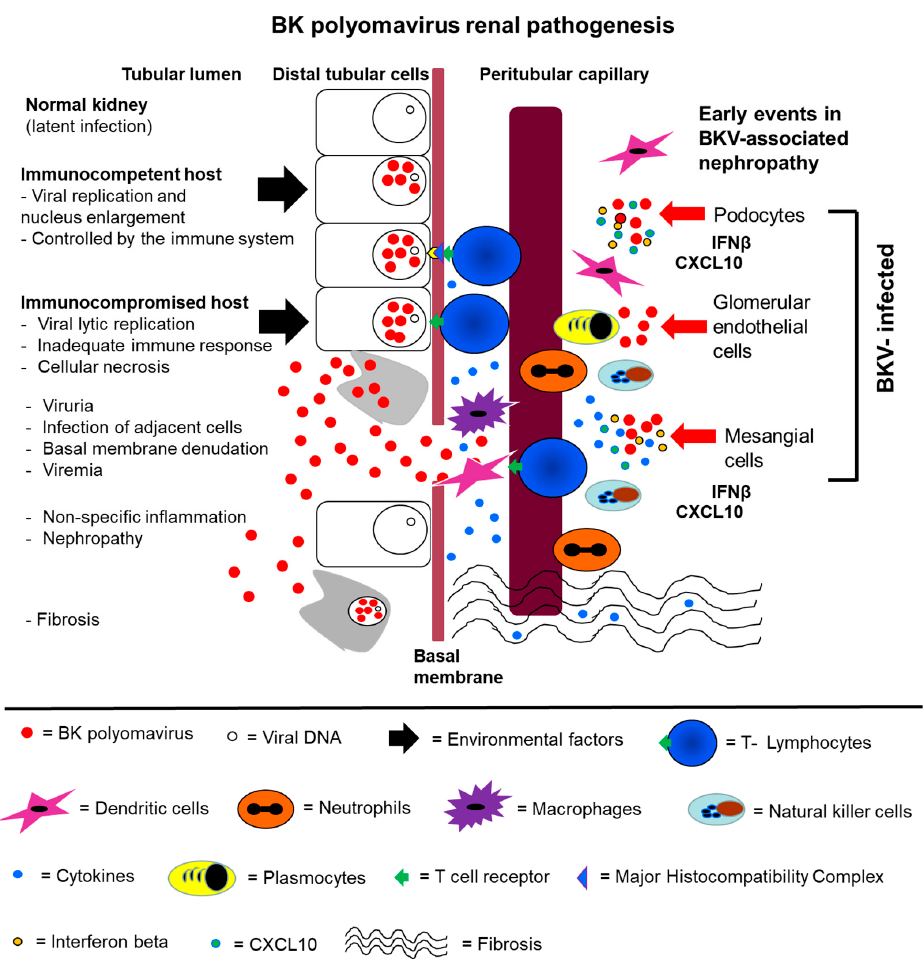
Figure 3. A hypothetical model for BKV pathogenesis that include infection of GVU cells. ( Left ) BKV (red spheres) infection of a normal kidney exists in the latent state in distal tubular epithelial cells.